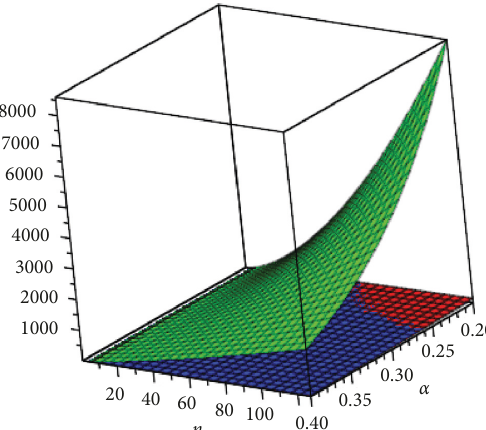
Figure 3: Comparison of ψ ω